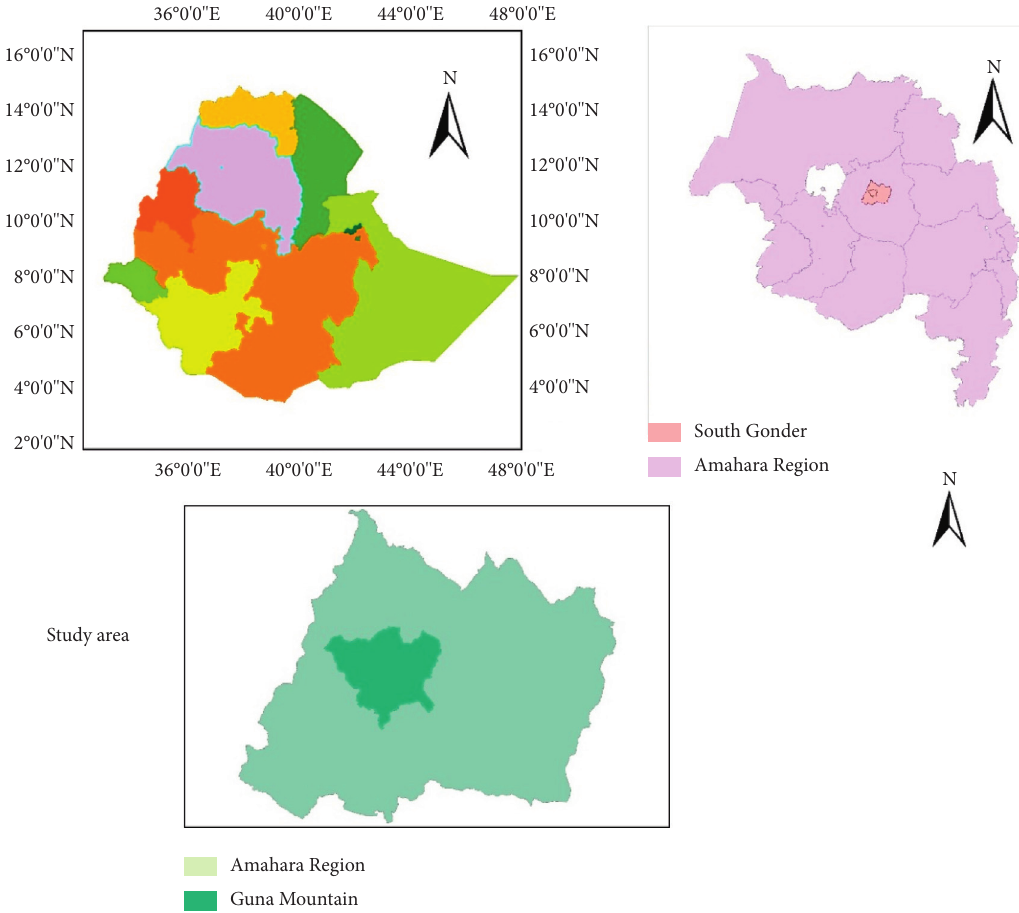
Figure 1: Map of the study area (Mt.